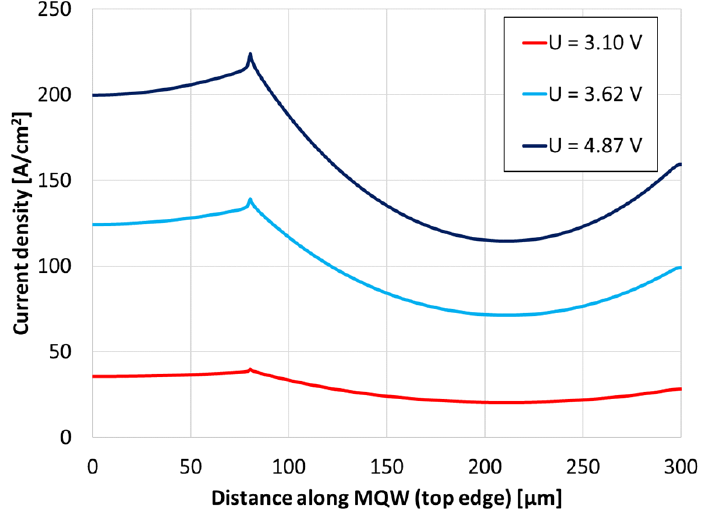
Figure 10. Current density distribution along the top edge of the MQW layer for three values of forward bias.